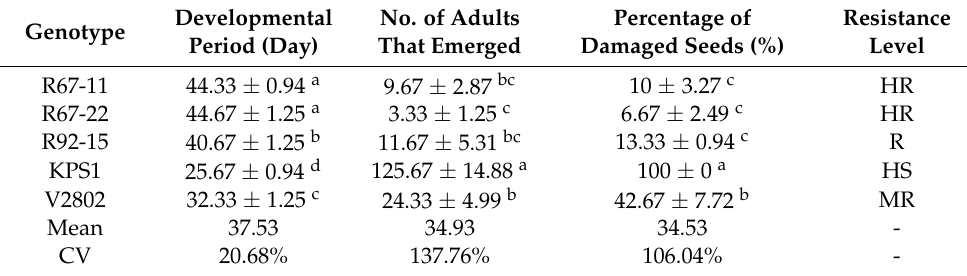
Means ± S.D. ( n = 3) in the same column with different letters were significantly different based on Duncan’s multiple comparisons ( p < 0.05). CV = coefficient of variation.